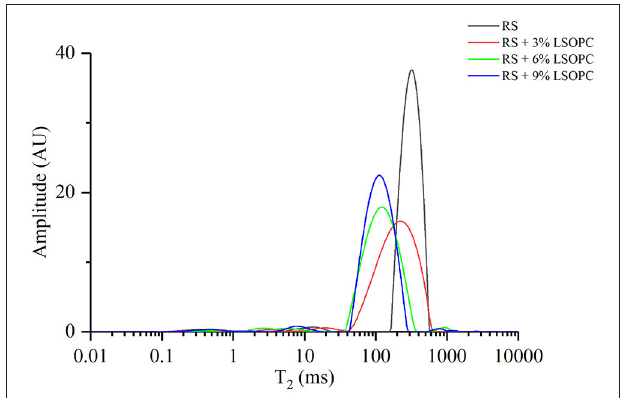
FIGURE 1 | LF-NMR spectra of RS with or without LSOPC.